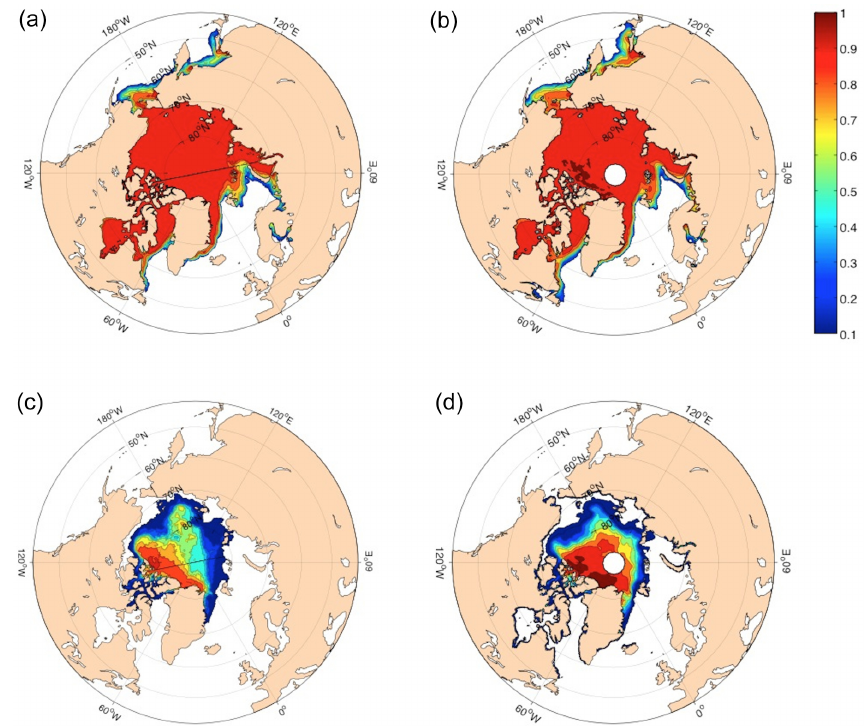
Figure 9. Maximum (a, b) and minimum (c, d) Arctic sea ice concentration for the period 2009–2013 in GLOB16 (left) and observational data set